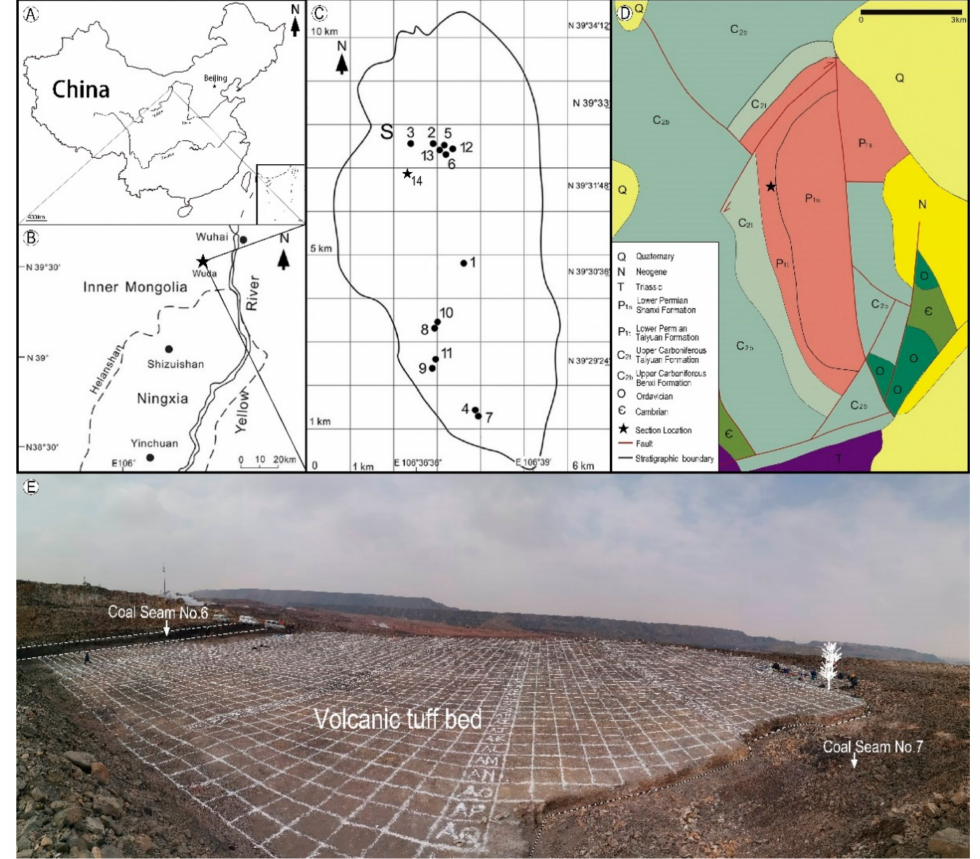
Figure 1. The location and stratigraphic horizon of study area. ( A – C ) The locality of the fossil materials, Wuda Coalfield, Inner Mongolia, China (No. 1–14 indicate locations where quantitative